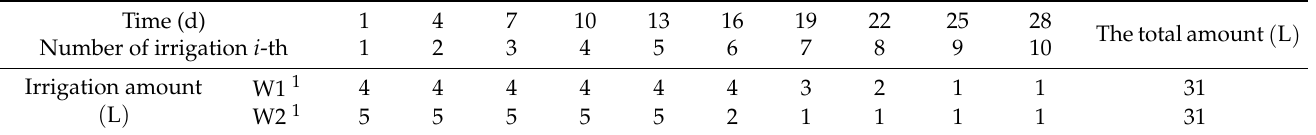
Table 1. Irrigation